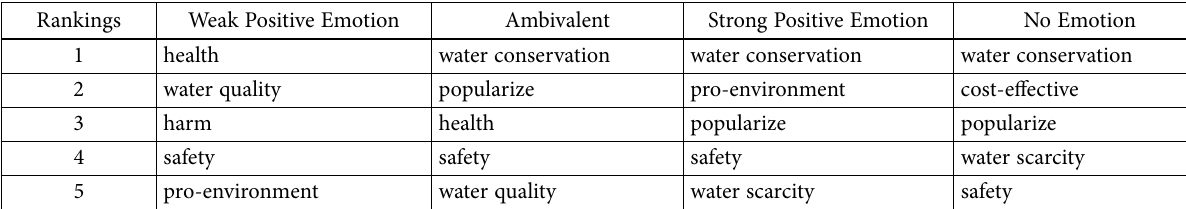
Table 1. Top 5 most frequently mentioned objects among the four